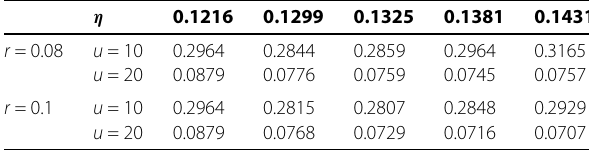
Table 1 Upper bounds of ruin probability for different η , u , and